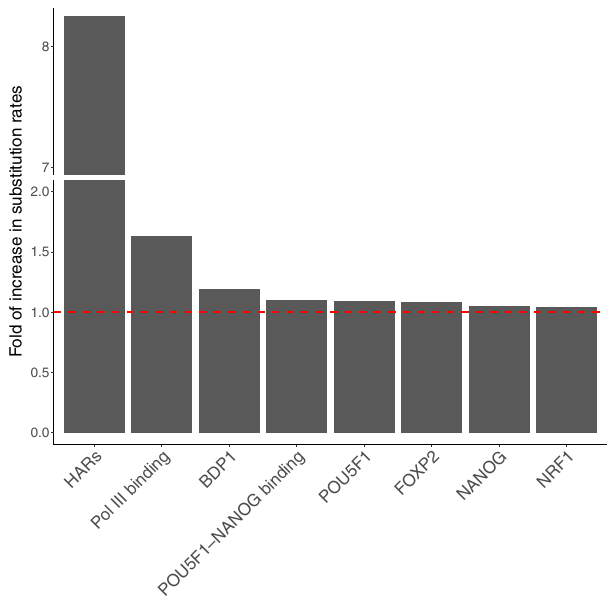
Fig. 6 | Non-overlapping TFBS groups under accelerated evolution in the humangenome. Thefoldofincreaseinsubstitutionrateisde fi nedas r 1 / r 2 ,where r 1 and r 2 aretherelativesubstitutionratesofaTFBSgroupinthehumanlineageandin other primates, respectively.